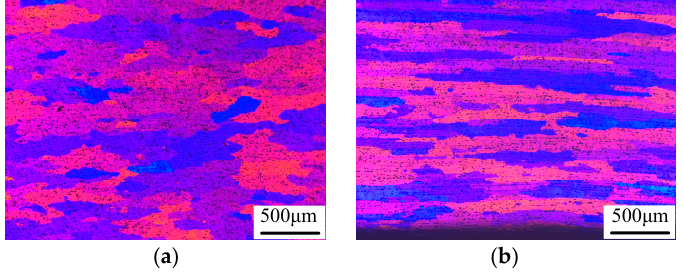
Figure 8. Microstructure of the frail position in HAZ of as-welded joints under different heat inputs: ( a ) plate No. 1, 7126.9 kJ; ( b ) plate No. 8, 3947.3 kJ.